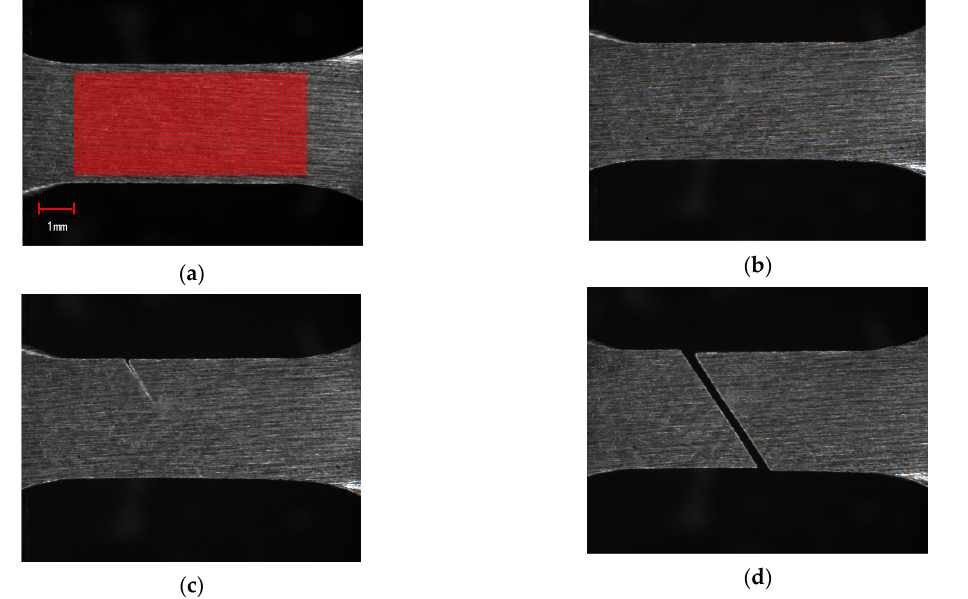
Figure 17. Images of the in-situ observation of a specimen. ( a ) Initial state, ( b ) elastic deformation stage, ( c ) necking stage, and ( d ) fracture